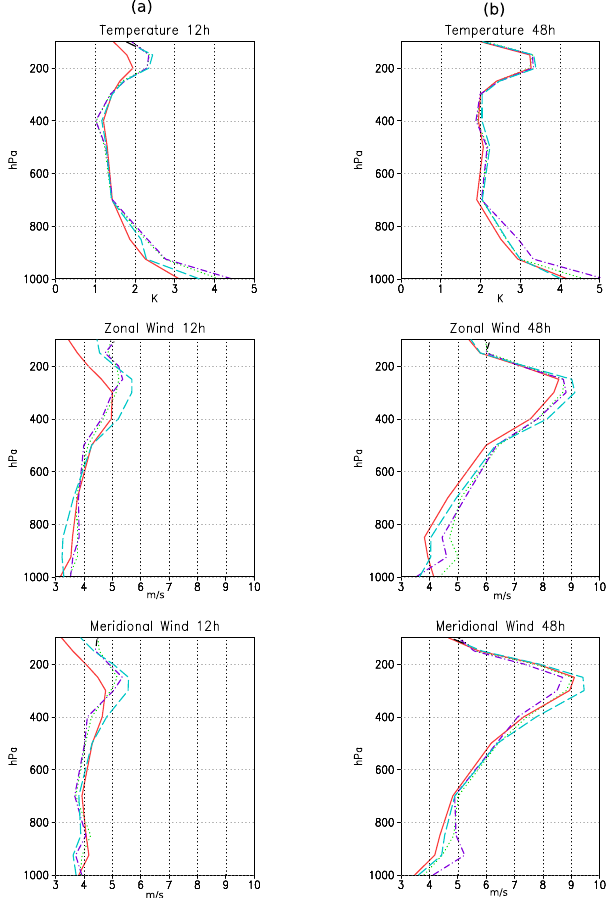
Fig. 12. Results for experiments assimilating observations of the real atmosphere. Vertical profile of the root-mean-square forecast error in the limited area domain at 12-h (a) and 48-h (b) forecast time for the global forecast (red solid), the global forecast with Strategy 4 (cyan dashes), the limited area forecast for Strategy 3 (green dots), and the limited area forecast Strategy 4 (purple dashes and